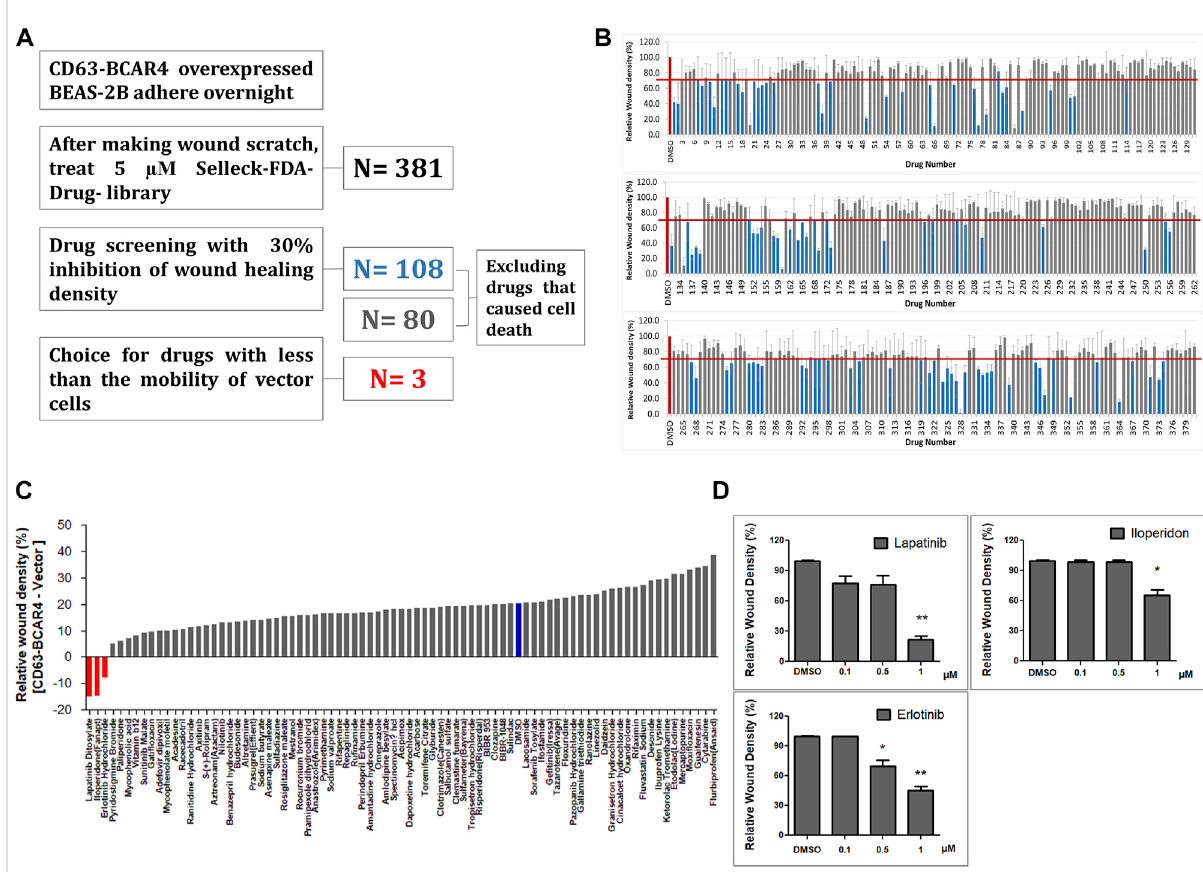
FIGURE 1 Drug library screening to identify inhibitors of cell migration induced by CD63-BCAR4 fusion. (A) Procedure to screen the drugs that effectively inhibit wound healing of BCAR4 fusion-overexpressing cells. (B) The bar graph represents the primary screening results of 381 FDA- approved drugs to compare inhibitory effect on cell migration. (C) Drug effects were simultaneously evaluated in both control cells (empty vector overexpressing cells) and CD63-BCAR4 overexpressing cells. The bar graph shows the ranking of candidate drugs that better inhibited the migration of BCAR4 fusion-overexpressing cells compared with the control cells. (D) Inhibitory effects of three drug candidates on wound healing were compared in a dose-dependent manner. Replicated experiments were performed and statistical signi fi cance are marked with * ( p < 0.05), and ** ( p <